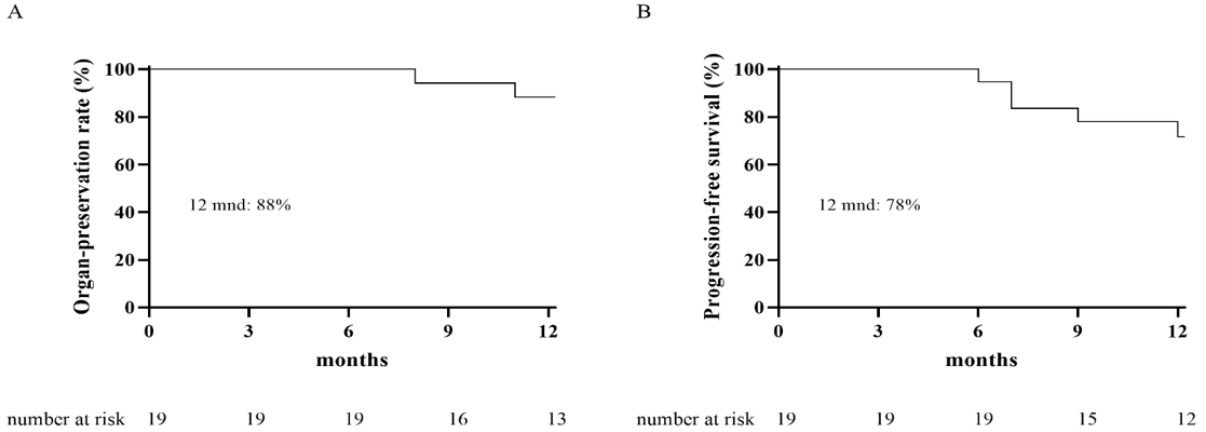
Figure 3. Kaplan-Meier curves for the organ-preservation rate ( A ) and progression-free survival ( B ).